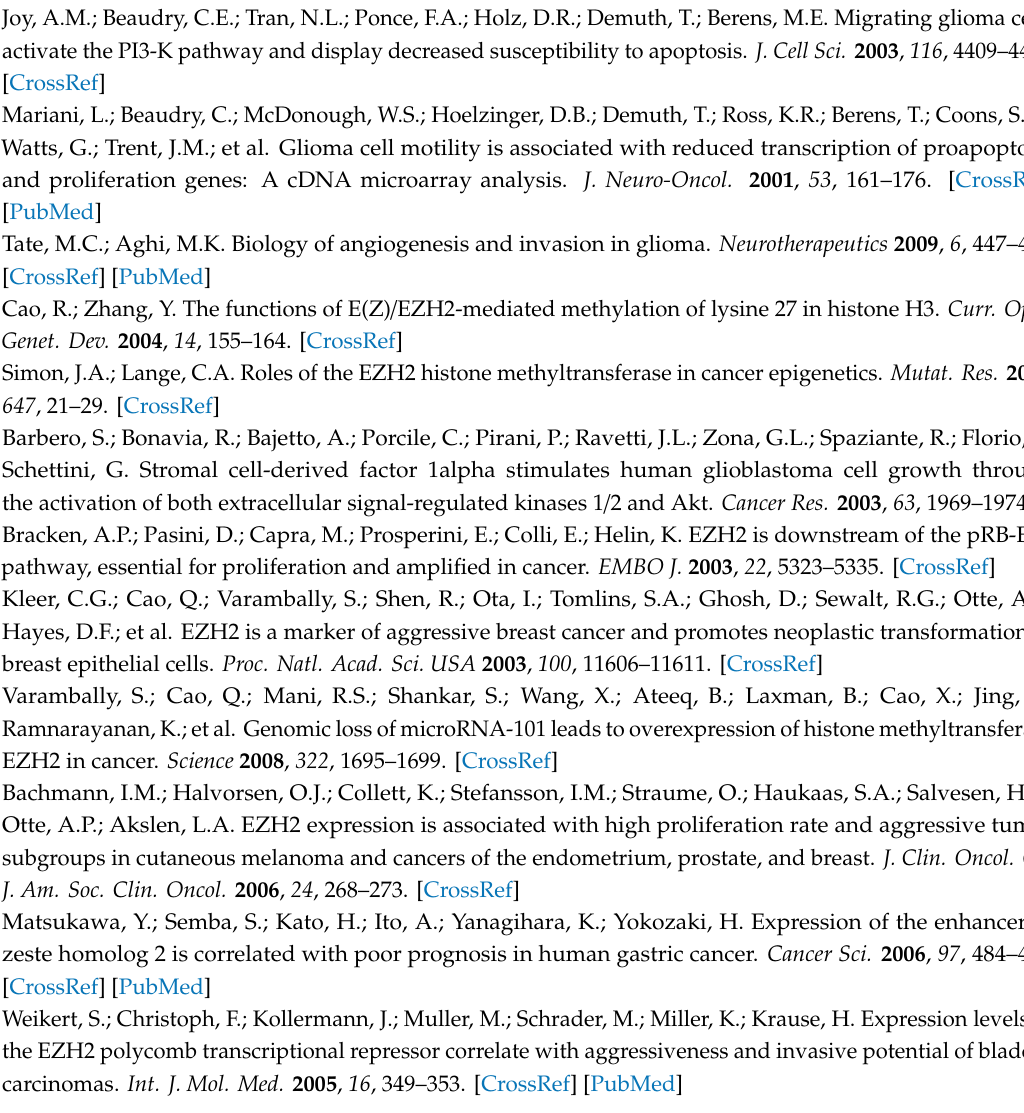
Figure S1: Raw data of Western blots from Figure 2, Figure S2: Raw data of Western blots from Figure 3, Figure S3: Raw data of Western blots from Figure